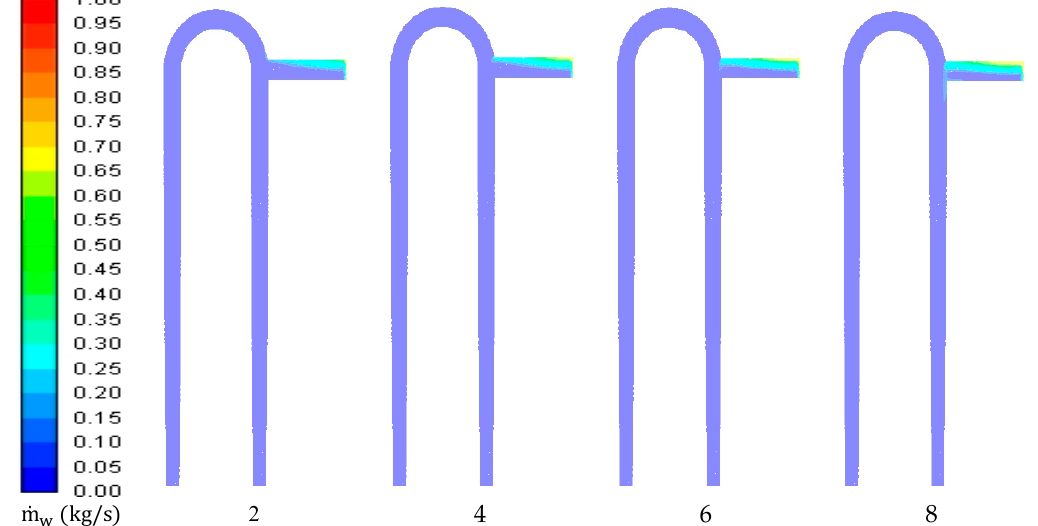
Figure 21. Vapor volume fraction contours at di ff erent flow ratios and X w = 6187.64, α m = 0.2 and X v = 0.5.